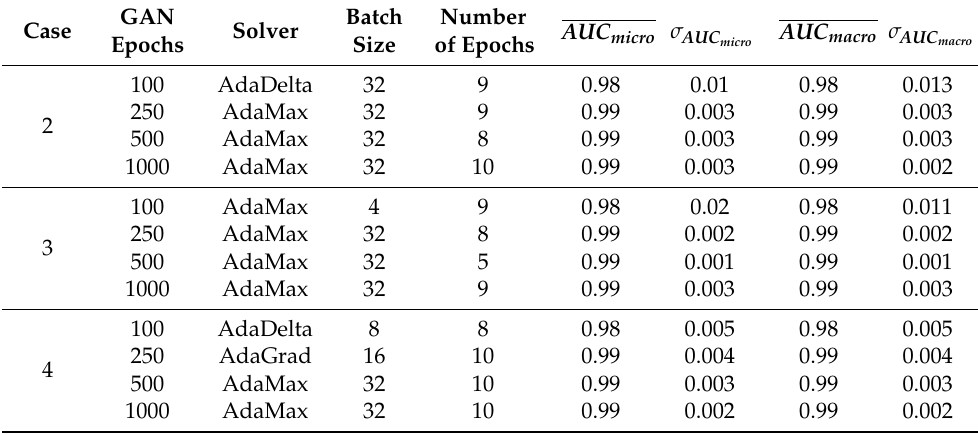
Table 6. Results achieved with AlexNet architecture.